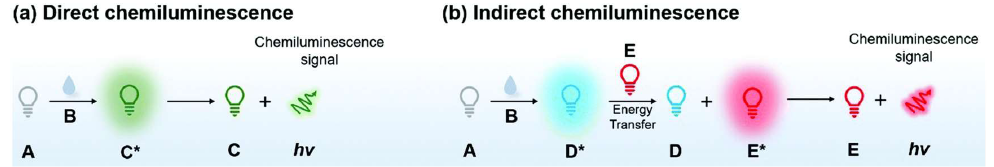
Figure 3. Schematic diagram of the mechanism of ( a ) direct and ( b ) indirect chemiluminescence. A: